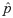
Perturbation response rate σ of the in-phase synchronized state for two coupled DPLLs.Perturbation response rate σ of the in-phase synchronized state in a system of two mutually coupled DPLLs, defined by Eq (17), for p^ given by Eq (29) with (A) a = 1 and ωc = 0.01ω and (B) a = 0. (C) Sign of α, Eq (14), as a function of the transmission delay. In all plots, shaded regions indicate where the in-phase synchronized state is stable. Regions where α > 0 coincide with the stability regions in (B). The other parameters are ω=2πrads-1, K = 0.1ω.